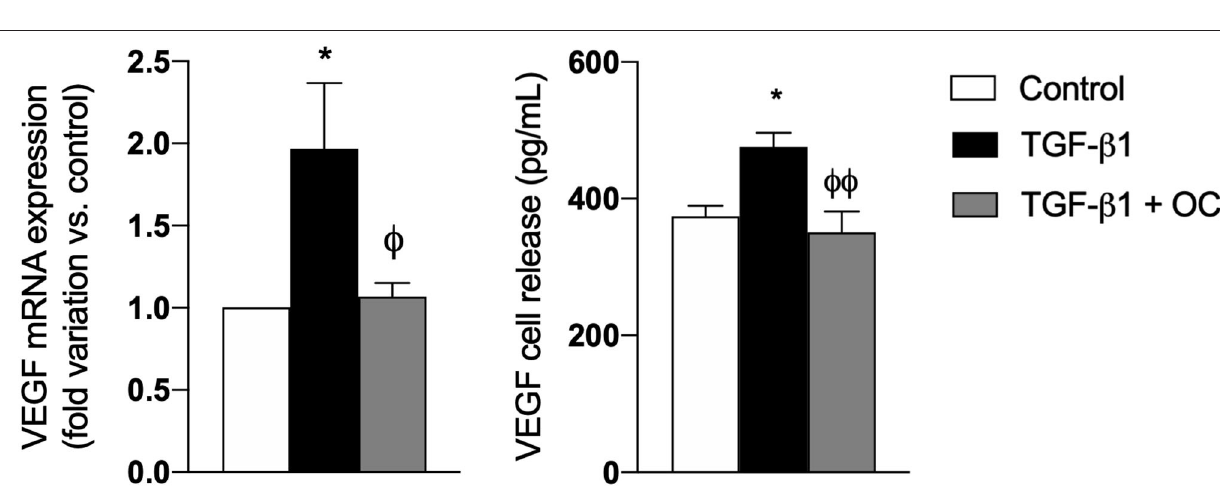
FIGURE 4 | Effect of OC on VEGF mRNA expression (A) and release (B) from LX2 cell line. * P < 0.05 vs. control, φ P < 0.05 vs. TGF- β 1 treated cells. φφ P < 0.01 vs. TGF- β 1 treated cells. Results are the mean of 3 independent experiments performed in triplicate (qRT-PCR) or in duplicate (ELISA) and have been analyzed by one-way ANOVA followed by the Tukey’s post hoc